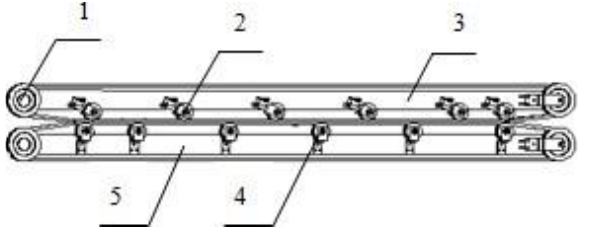
Figure 7. Clamping conveyor. 1. Belt pulley. 2. Movable tension roller. 3. Right clamping conveyor frame. 4. Fixed tension roller. 5. Left clamping conveyor frame.